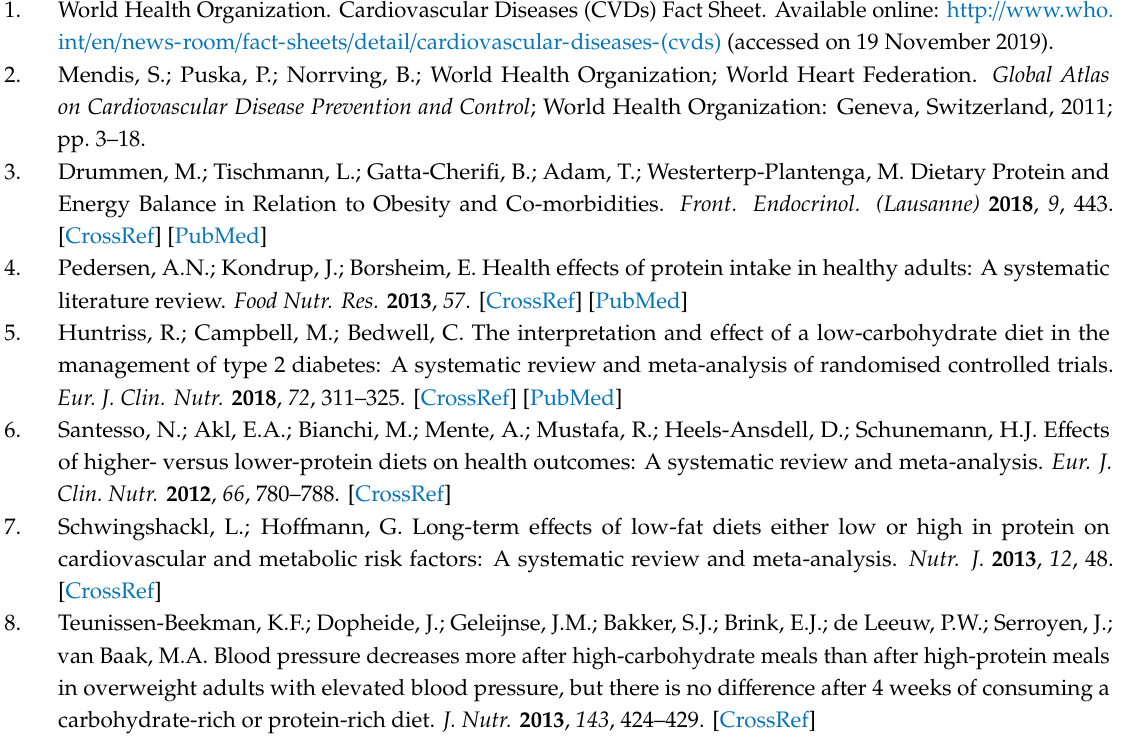
Table S1: Subject characteristics of the moderate- and high-protein group prior to the respiration chamber stay. Table S2: O ffi ce blood pressure at pre- and post-respiration chamber time points with a moderate- or high-protein